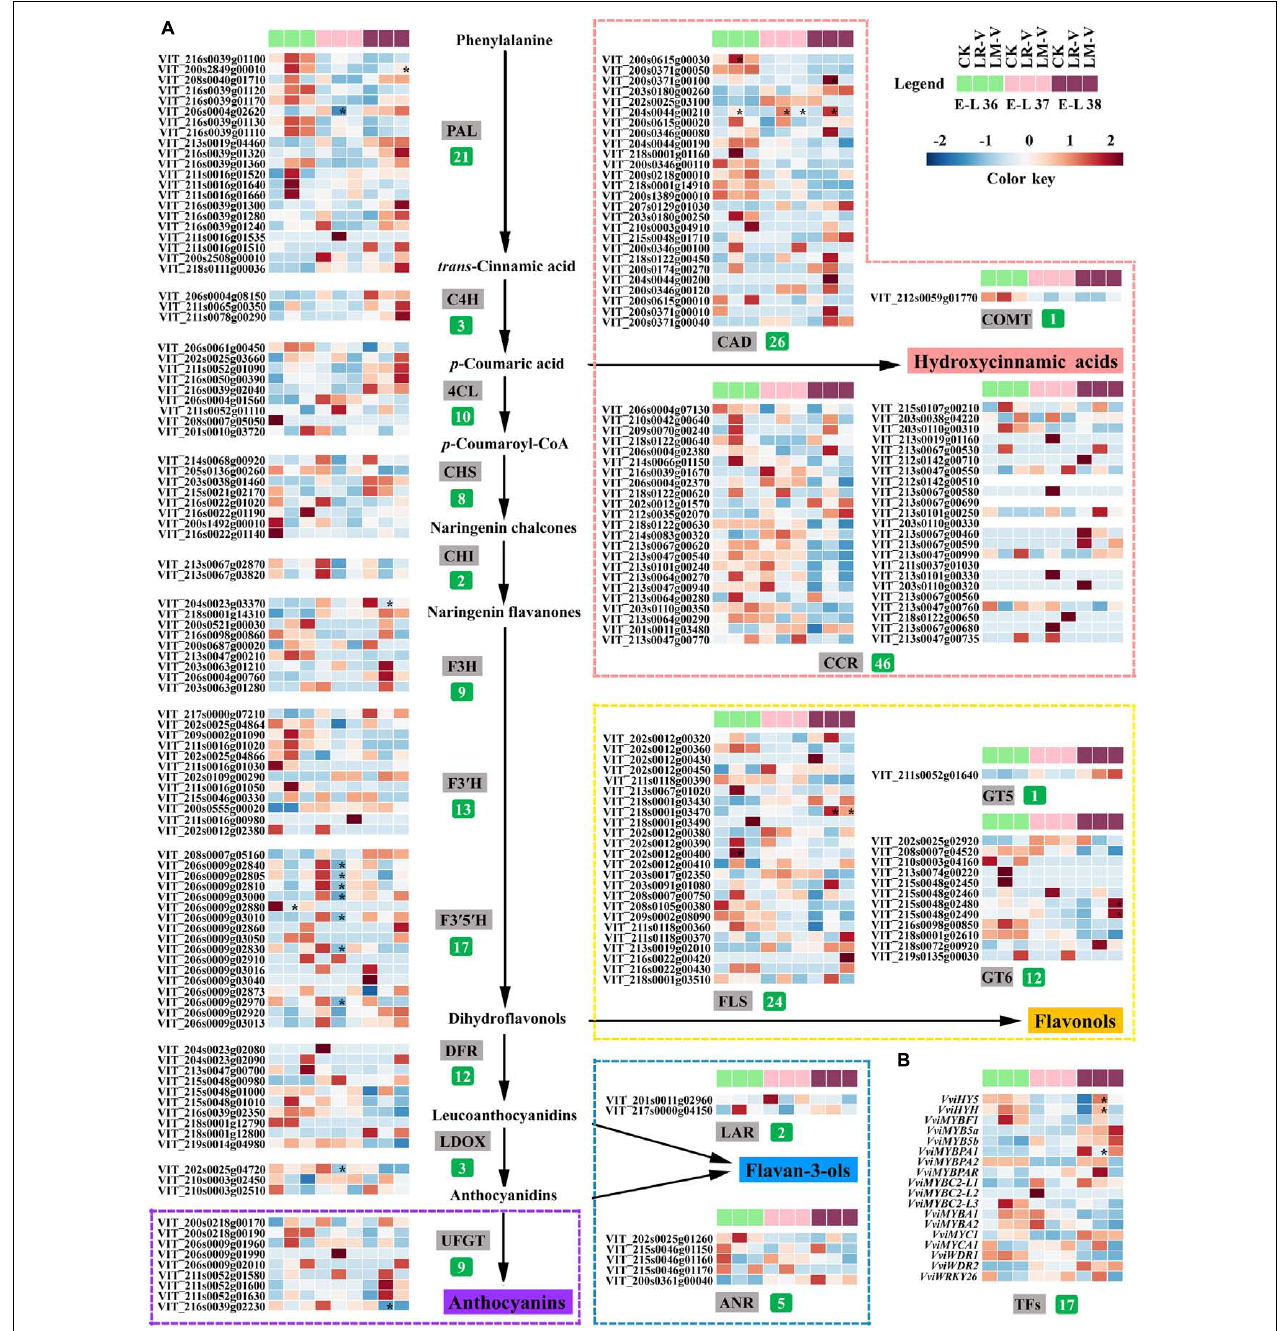
FIGURE 4 | Effects of sunlight exposure on the transcript profile of the (A) enzymes and (B) regulatory factors involved in phenolic biosynthesis in grape berries. PAL, phenylalanine ammonia-lyase; C4H, trans -cinnamate 4-monooxygenase; CCR, cinnamoyl-CoA reductase; CAD, cinnamyl-alcohol dehydrogenase; COMT, caffeic acid 3- O -methyltransferase; 4CL, 4-coumarate: CoA ligase; CHS:,chalcone synthase; CHI, chalcone isomerase; F3H, flavanone 3-hydroxylase; F3 (cid:48) H, flavonoid 3 (cid:48) -hydroxylase; F3 (cid:48) 5 (cid:48) H: flavonoid 3 (cid:48) ,5 (cid:48) -hydroxylase; FLS, flavonol synthase; GT5, uridine diphosphate (UDP)-glucuronic acid:flavonol-3- O -glucuronosyltransferase; GT6, bifunctional UDP-glucose/UDP-galactose:flavonol-3- O -glucosyltransferase/galactosyltransferase; DFR, dihydroflavonol reductase; LAR, leucoanthocyanidin reductase; LDOX, leucoanthocyanidin dioxygenase; ANR, anthocyanidin reductase; UFGT, UDP-glucose:flavonoid 3- O -glucosyltransferase. The number of expressed family members for each enzyme is indicated in green box. Each square in the heatmap located beside their gene names corresponds to the average FPKM value of the gene in each sample as illustrated in the legend. Genes with significant expression changes compared with the control groups in each developmental stage are indicated by asterisks ( ∗ ) in the squares. Expression profiles of specific structural genes required for the biosynthesis of HCAs, flavonols, flavan-3-ols and anthocyanins are shown in pink, yellow, and violet dotted boxes, respectively. C, control group; LR-V, leaf removal at véraison; LM-V, leaf moving at véraison.